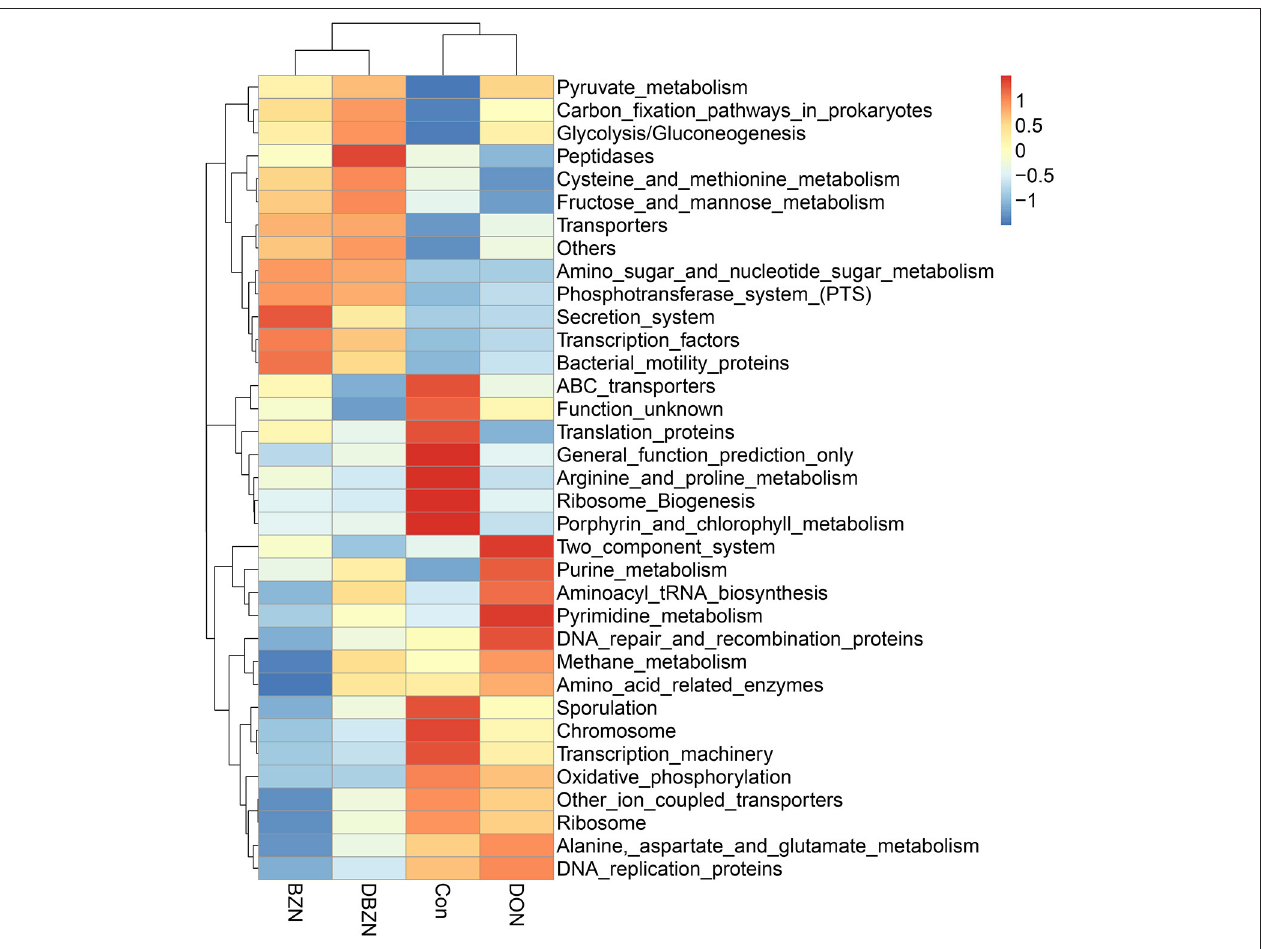
FIGURE 3 | BZN supplementation changed the metabolic functions of intestinal microbiome of piglet at KEGG level 3. Dietary treatment: Con, basal diet; DON, 4 mg/kg DON-contaminated diet; BZN, 0.5% BZN supplementation diet; DBZN, 0.5% BZN supplement in 4 mg/kg DON-contaminated diet. BZN, baicalin–zinc complex; Con, control; DON, deoxynivalenol; KEGG, Kyoto Encyclopedia of Genes and